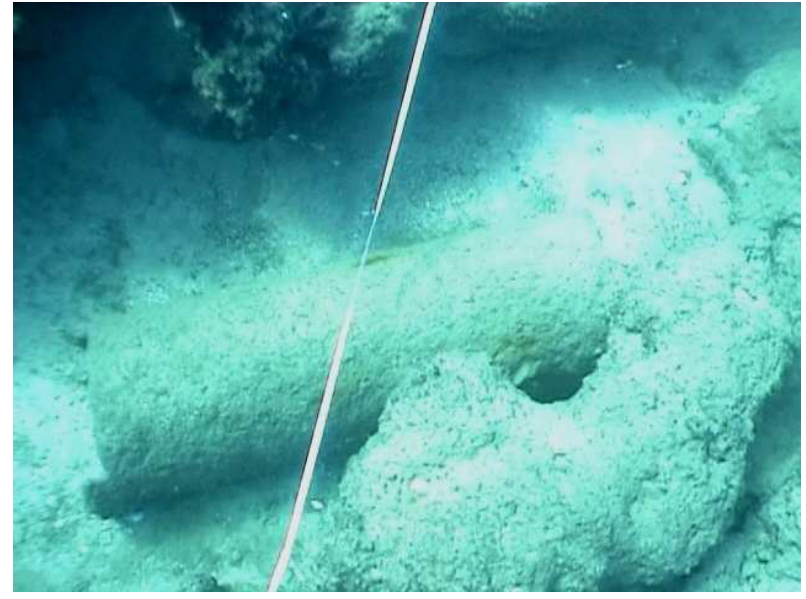
Figure 11. Anomaly number 4 found at a depth of 9 m on the seabed. The artifact is a thick wall steel